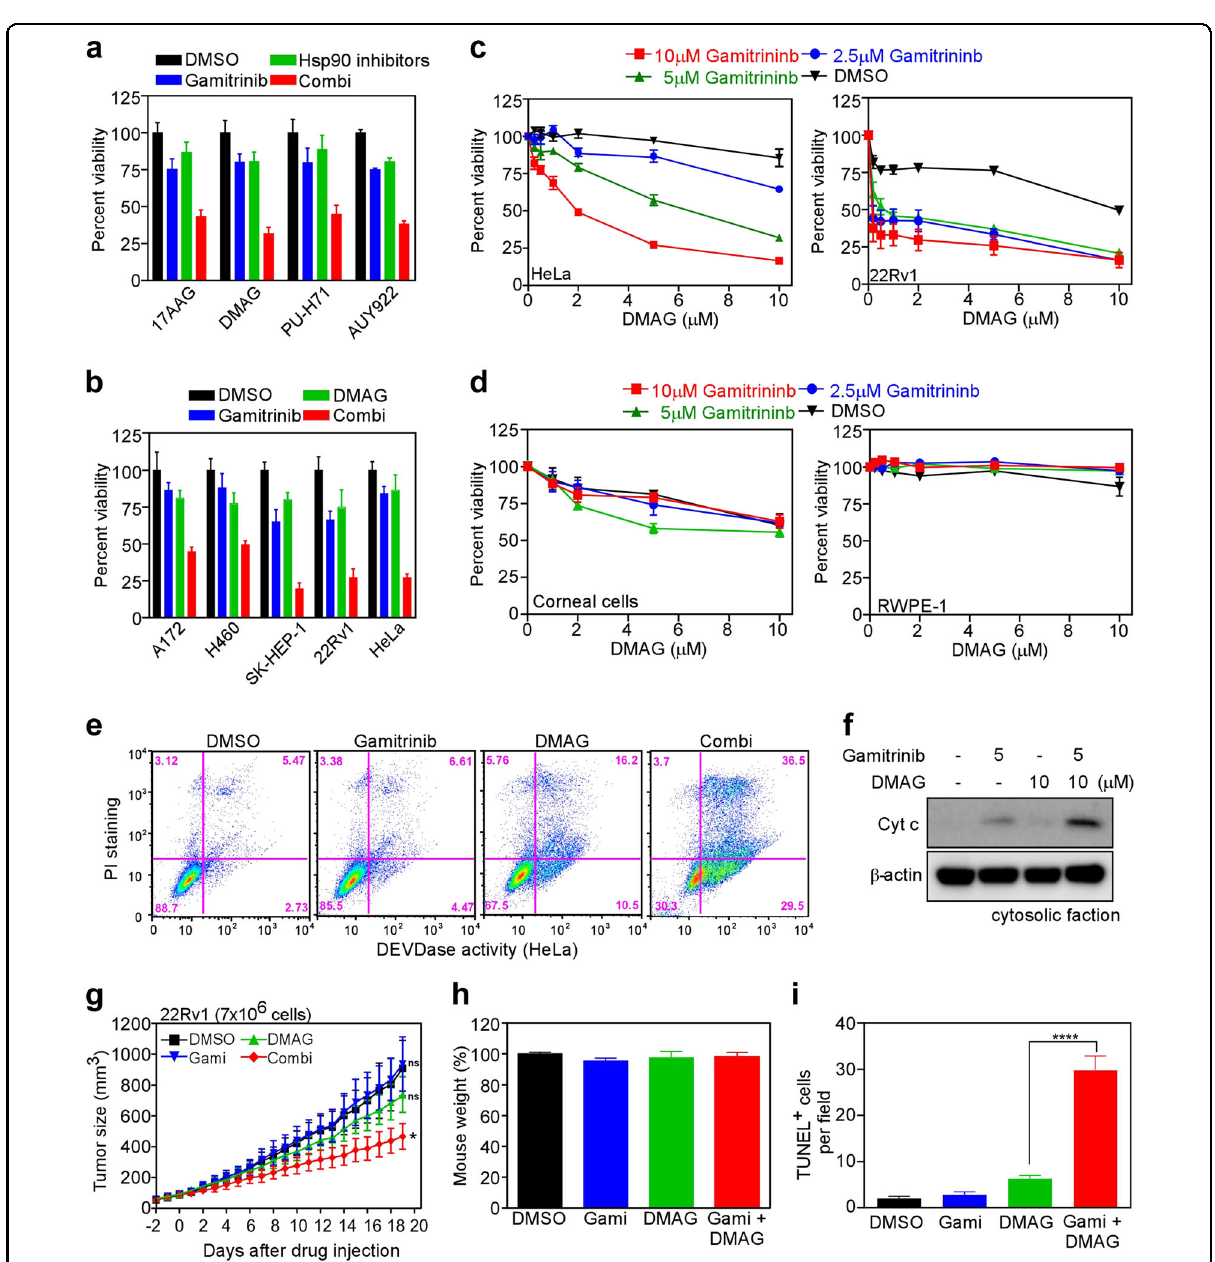
Fig. 2 Synergistic anticancer effects of combined treatment with gamitrinib and Hsp90 inhibitors. a Combined treatment with Hsp90 inhibitors plus gamitrinib. HeLa cells were treated with 5 μ M gamitrinib and 10 μ M Hsp90 inhibitors for 24 h and then analyzed by the MTT assay. b Effect of combined drug treatment on various cancer cell lines. 22Rv1 cells were treated for 24 h with 2.5 μ M gamitrinib and 5 μ M DAMG, and other cells were treated with 5 μ M gamitrinib and 10 μ M DMAG, either alone or in combination, and then analyzed by the MTT assay. c Synergistic cytotoxic activity. HeLa and 22Rv1 cells were treated with various concentrations of DMAG in the presence of 2.5, 5, and 10 μ M gamitrinib and then analyzed by the MTT assay. d Cytotoxicity against human normal cells. Primary human corneal cells and normal human prostate normal cells (RWPE- 1) were treated for 24 h with drugs and then analyzed by the MTT assay. e Induction of apoptosis. HeLa cells were treated for 24 h with 5 μ M gamitrinib and 10 μ M DMAG, either alone or in combination, stained with propidium iodide (PI) and FITC-DEVD-fmk, and then analyzed by fl ow cytometry. f Cytochrome c (Cyt C) discharge from mitochondria. HeLa cells were treated for 18 h with drugs, and cytosolic fractions were analyzed by western blotting. g Tumor xenograft experiment. 22Rv1 cells were implanted subcutaneously into nude mice. Mice received 10 mg/kg DMAG (i.p.) and 10 mg/kg gamitrinib (i.p.), either alone or in combination, twice/week. Tumor volume was assessed daily by caliper measurement. Three mice per group/two tumors per animal. h Body weight changes were measured prior to sacri fi ce. i Apoptosis of tumor tissues was analyzed by the TUNEL assay. All data represent the mean ± SEM; * p < 0.05, **** p < 0.0001.